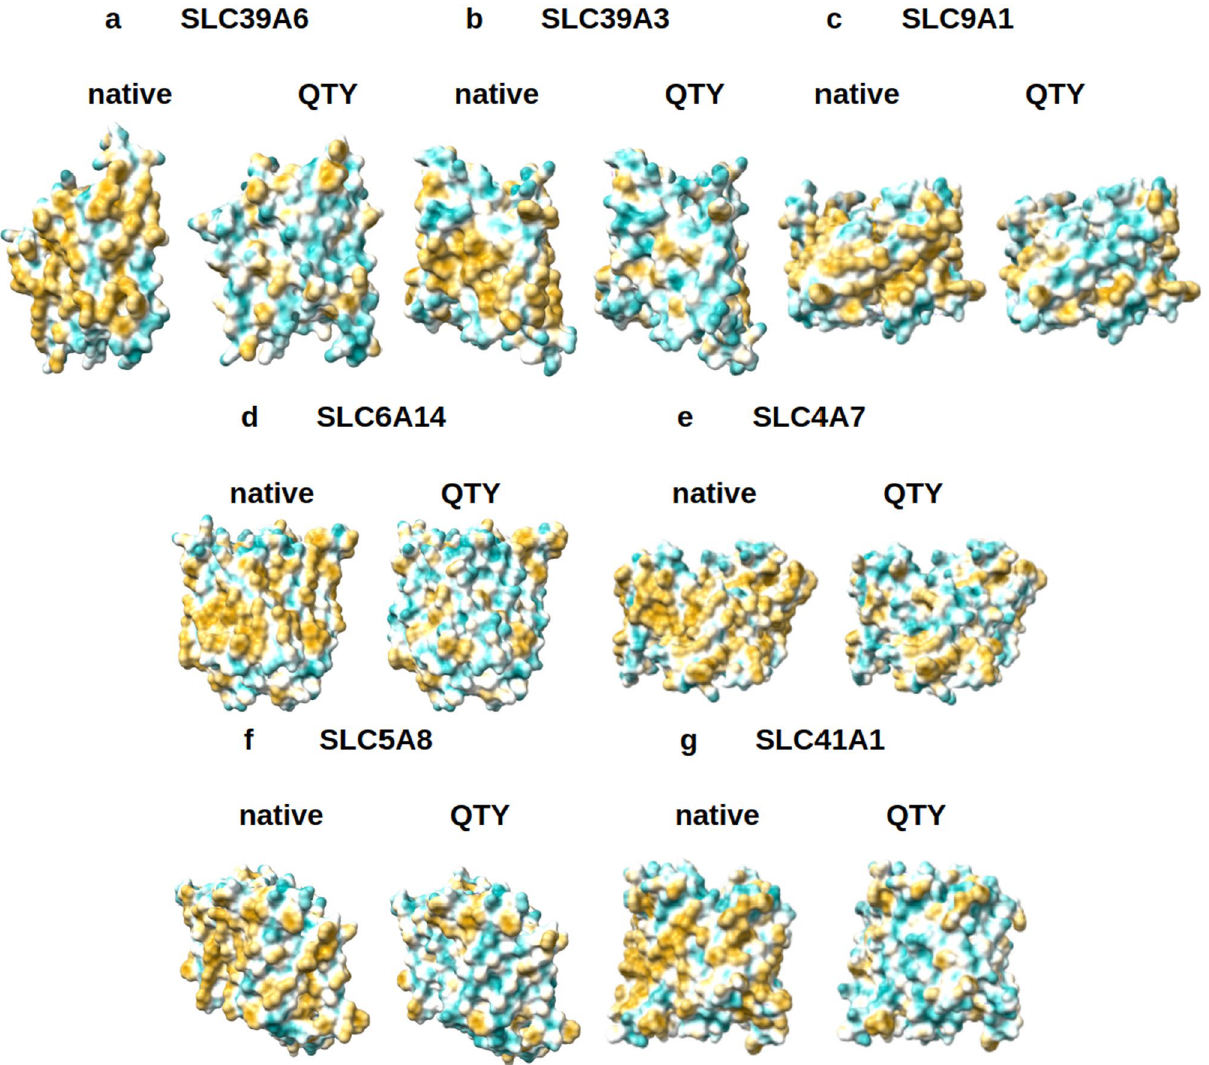
Figure 6. Hydrophobic surface of 8 AlphaFold2 predicted native solute carrier transporters and their QTY variants. The pairwise of AlphaFold2 predicted native transporters with hydrophobic surface (brownish color), and the QTY variant transporters (cyan color). ( a ) SLC39A6 versus SLC39A6 QTY , ( b ) SLC39A3 versus SLC39A3 QTY , ( c ) SLC9A1 versus SLC9A1 QTY , ( d ) SLC6A14 versus SLC6A14 QTY , ( e ) SLC4A7 versus SLC4A7 QTY , ( f ) SLC5A8 versus SLC5A8 QTY , ( g ) SLC41A1 versus SLC41A1 QTY . For clarity, the large N- terminus and C-terminus are